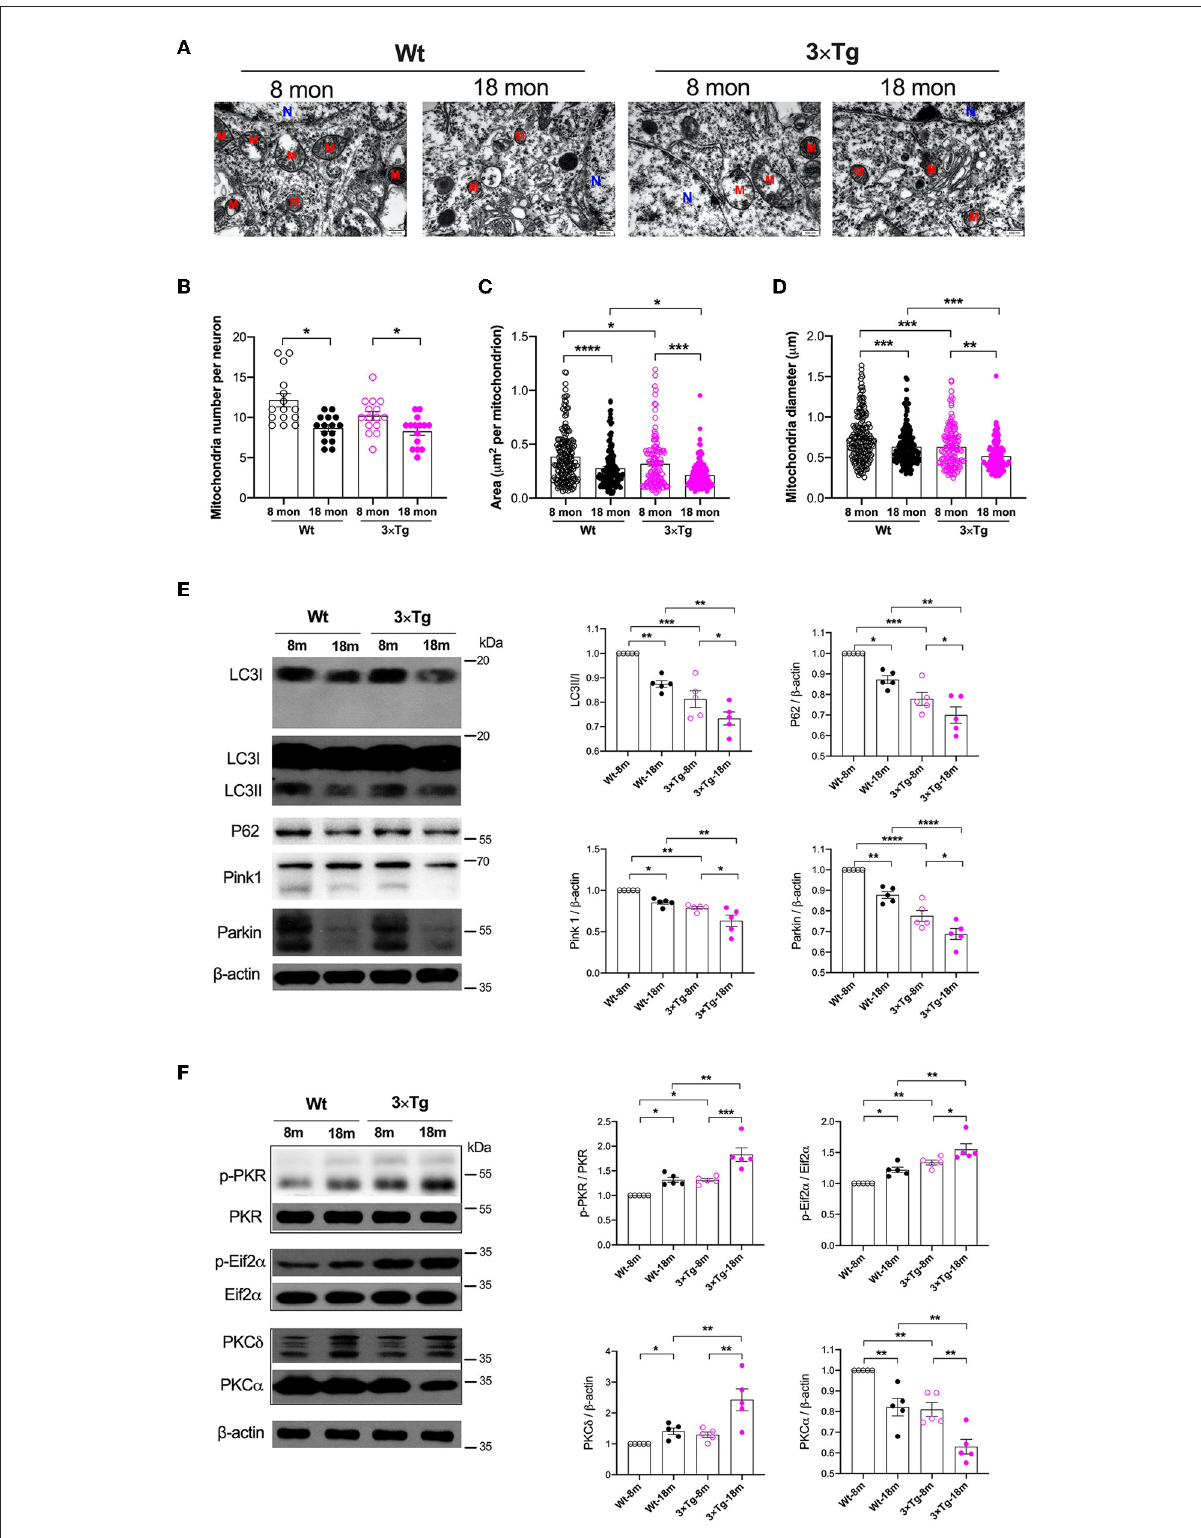
FIGURE1 Variations of mitochondria and autophagy during aging in the wild-type and 3 × Tg AD mice. (A) Representative electron microscopy photographs of mitochondria in the hippocampal neurons in different ages of wild-type and transgenic AD mice (N, nucleus; M, mitochondria; scale bar = 500nm). (B–D) Quantification of mitochondrial number, area, and diameter in the hippocampal tissues from two strains of mice by